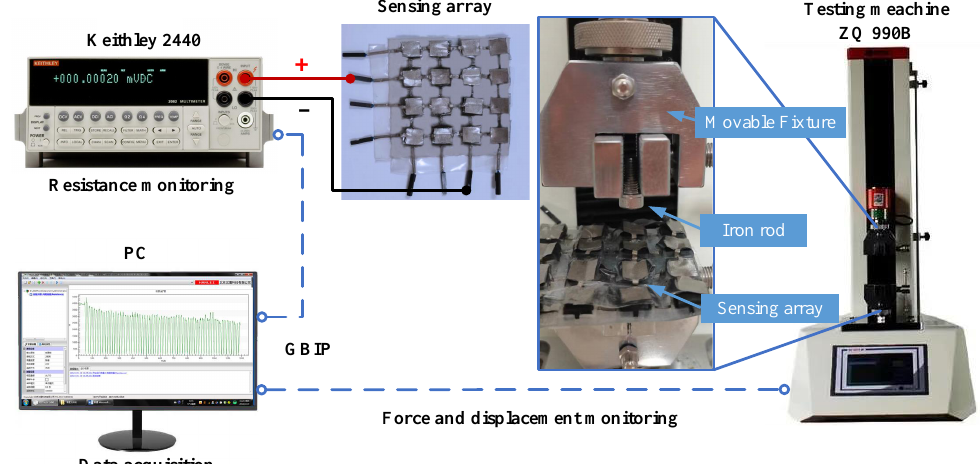
Figure 5. The configuration of the calibration and stability testing